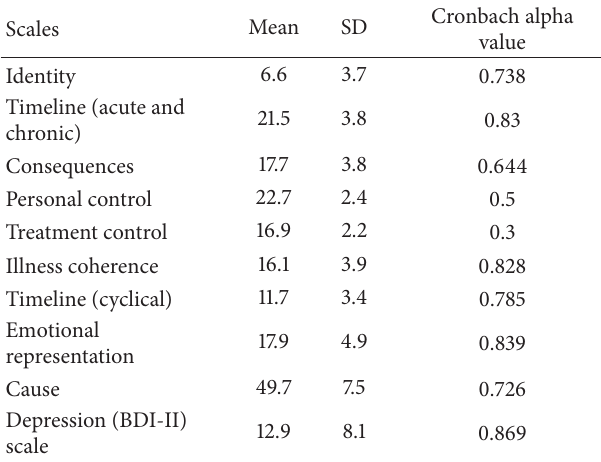
Table 2: Reliability test (Cronbach alpha) for illness perception and BDI-II